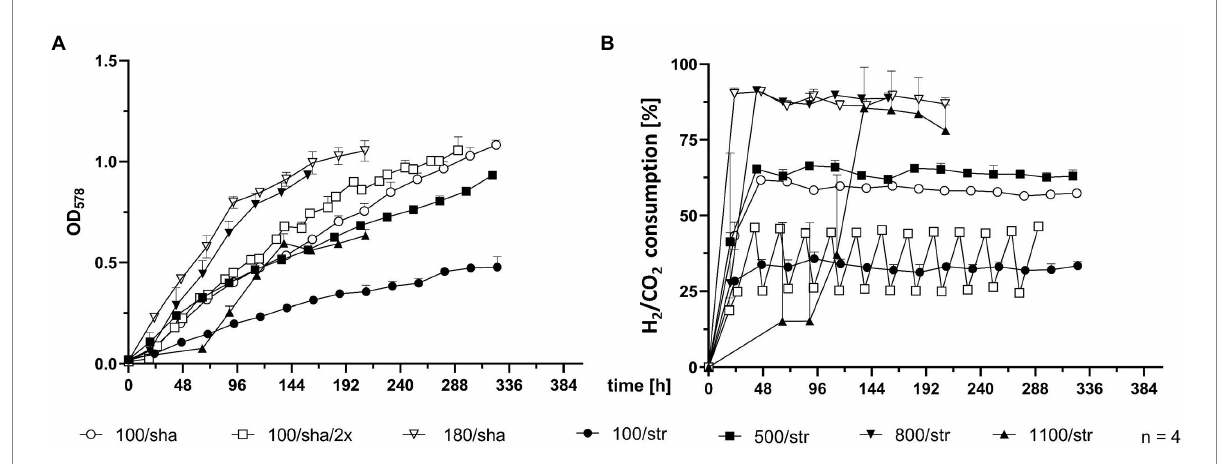
FIGURE 2 Comparison of 0.4 L SCB cultures. (A) OD 578 measured over time in h. (B) substrate consumption, measured in % conversion of substrate (H 2 /CO 2 ) into product (CH 4 ) over time in h. All data points are calculated mean values of biological quadruplicates ( n = 4). Further details are presented in Table